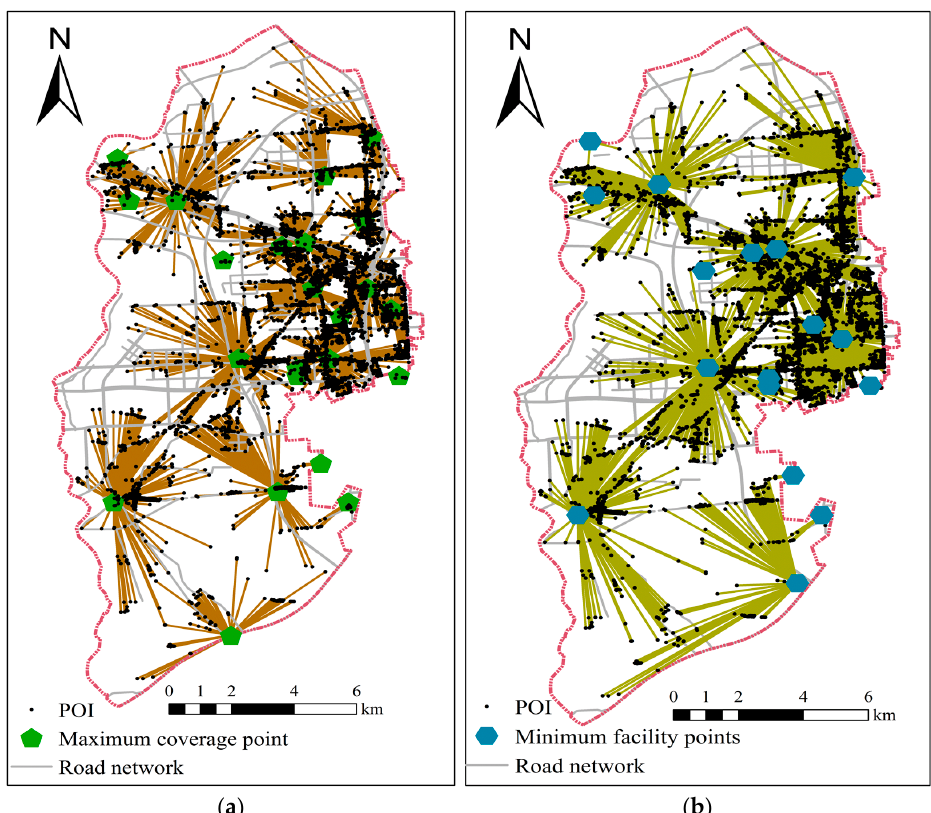
Figure 4. The spatial distribution results obtained from the simulation, ( a ) maximum coverage points; ( b ) minimum facility points. ( b ) minimum facility